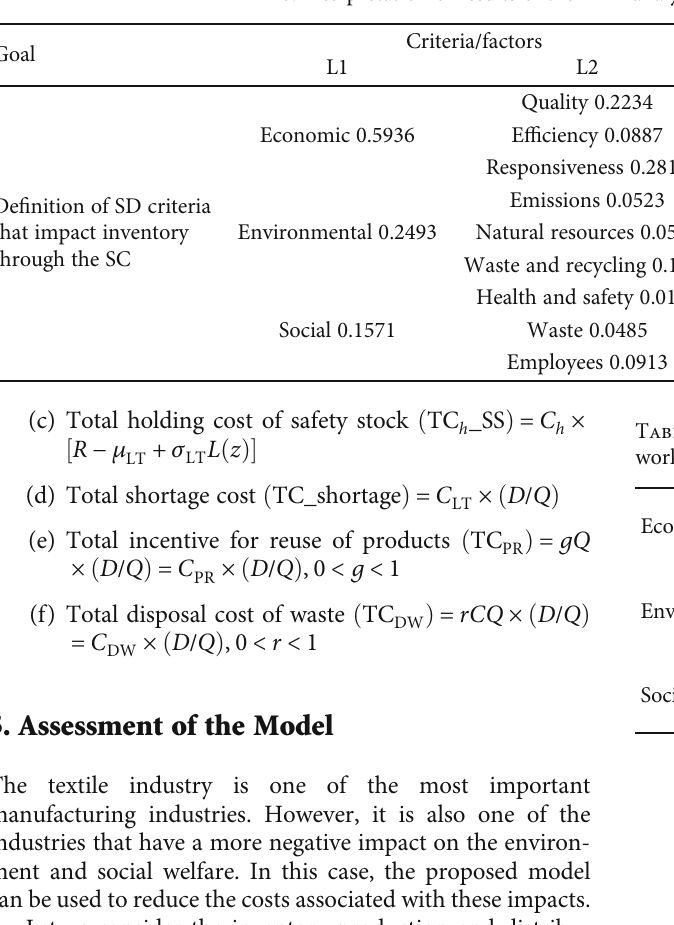
Table 6: Interpretation of results of the AHP analysis presented in Table 5 (own work).